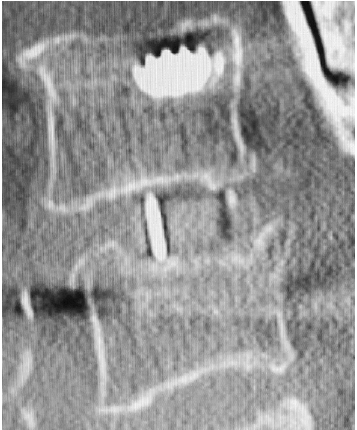
Figure 1. Cage subsidence examples. Polyetheretherketone cage single-level lateral lumbar interbody fusion (LLIF) postoperative computed tomography (CT) shows cage subsidence on the caudal endplate of the disc.